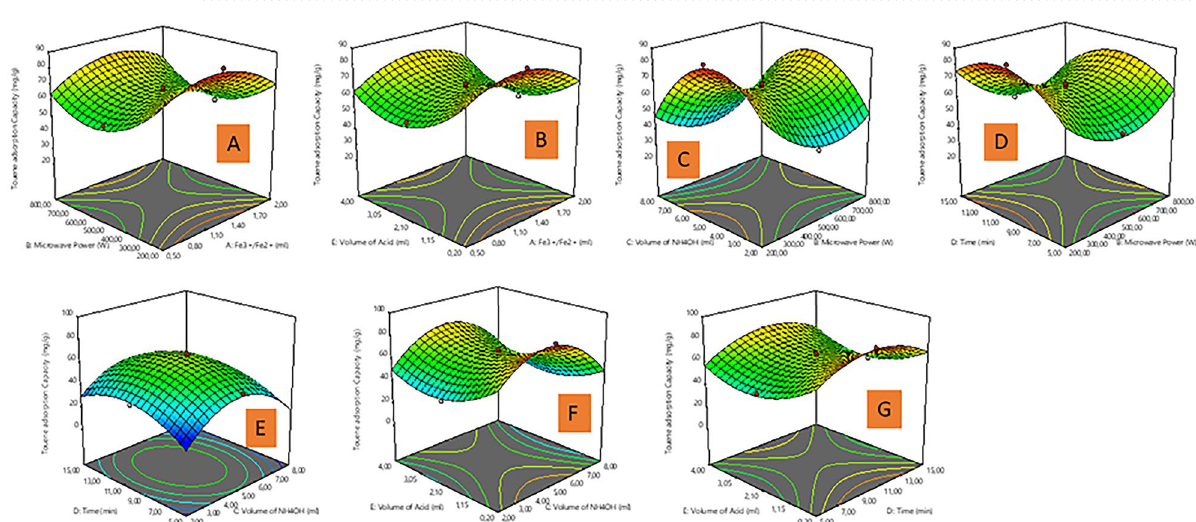
Figure 3. 3D response plots of ( A ) Fe 3+/ Fe 2+ solution and microwave power, ( B ) Fe 3+/ Fe 2+ solution and volume of ammonium hydroxide, ( C ) Fe 3+/ Fe 2+ solution and volume of oleic acid, ( D ) microwave power and volume of ammonium hydroxide, ( E ) microwave power and time, ( F ) volume of ammonium hydroxide and time, ( G ) volume of ammonium hydroxide and volume of oleic acid, ( H ) time and volume of oleic acid on benzene adsorption capacity (BAC).